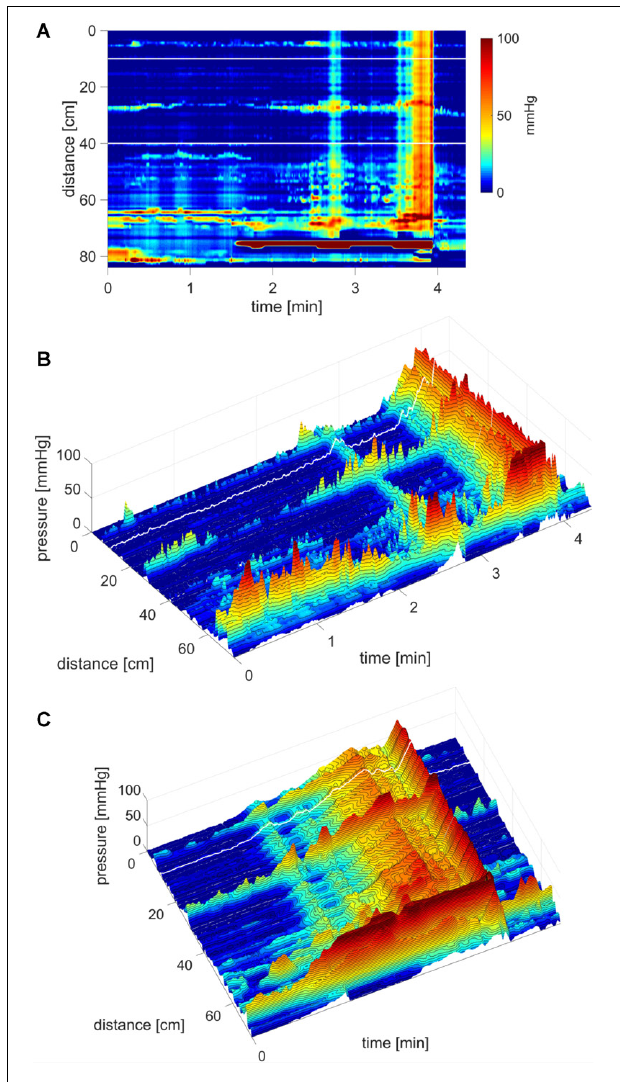
FIGURE 11 | A high amplitude SPW associated with balloon expulsion. (A) Two SPWs appear in response to rectal balloon distention; the dark area above the anal sphincter shows the pressure in the rectum induced by the balloon. The first SPW was associated with liquid outflow. The second SPW consists of a cluster of high frequency multiple pressure waves, the last wave at 55 mmHg is followed by relaxation of the sphincter and it expels the balloon. Preceding the balloon expulsion, the SPW was associated with pain and urge. (B) 3D image of (C) , the balloon distention and anal sphincter activity was removed to make the SPW better visible. (C) Close up of the second SPW as shown in (B) where its composition of multiple pressure waves is clearly